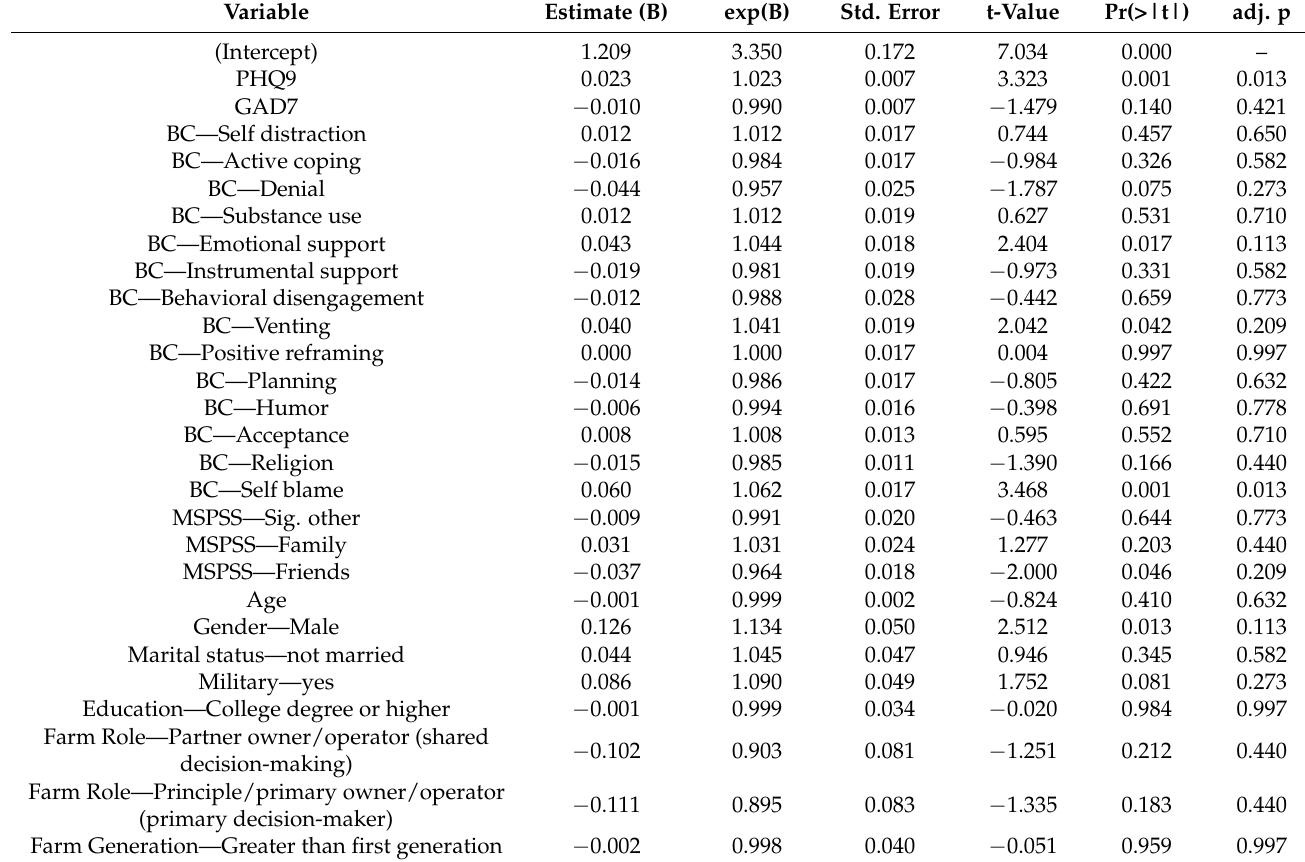
Table 3. Model 1: Multiple linear regression model to analyze associations with the natural log-transformed suicide risk (SBQ-R), including depression (PHQ-9), anxiety (GAD-7), Brief COPE subscales (BC), social support (MSPSS), and select demographic and farming